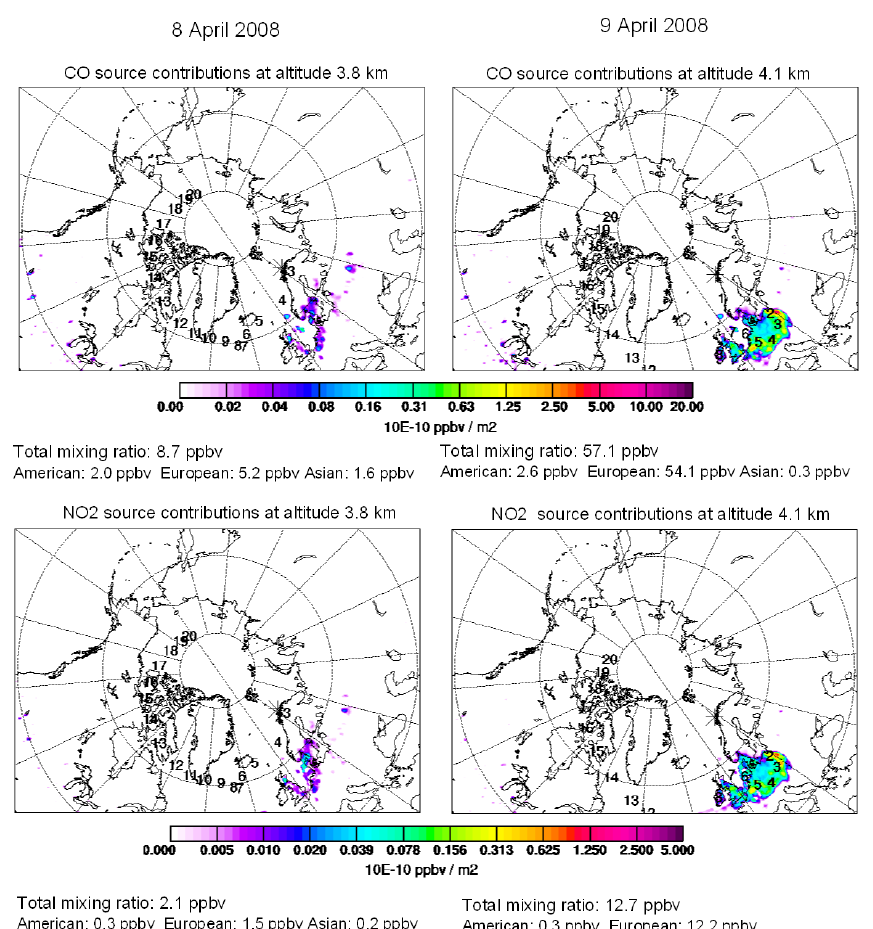
Fig. 15. CO and NO 2 source contributions for the altitude with maximum CO concentration in the two soundings. Europe appears the dominant source and its influence is much larger on the second sounding (9 April 2008).